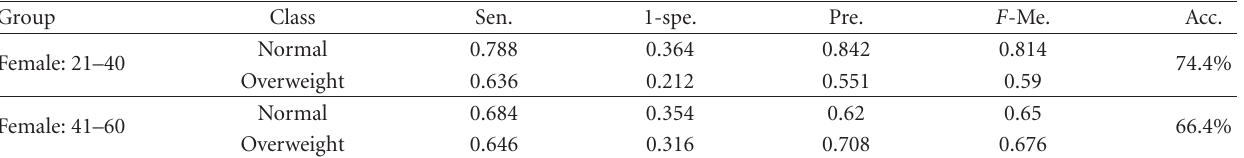
Table 4: Detailed performance evaluation of experiments without the use of MDL method (Sen.: sensitivity, 1-spe.: 1-specificity, Pre.: precision, F -Me.: F -measure, and Acc.: accuracy).